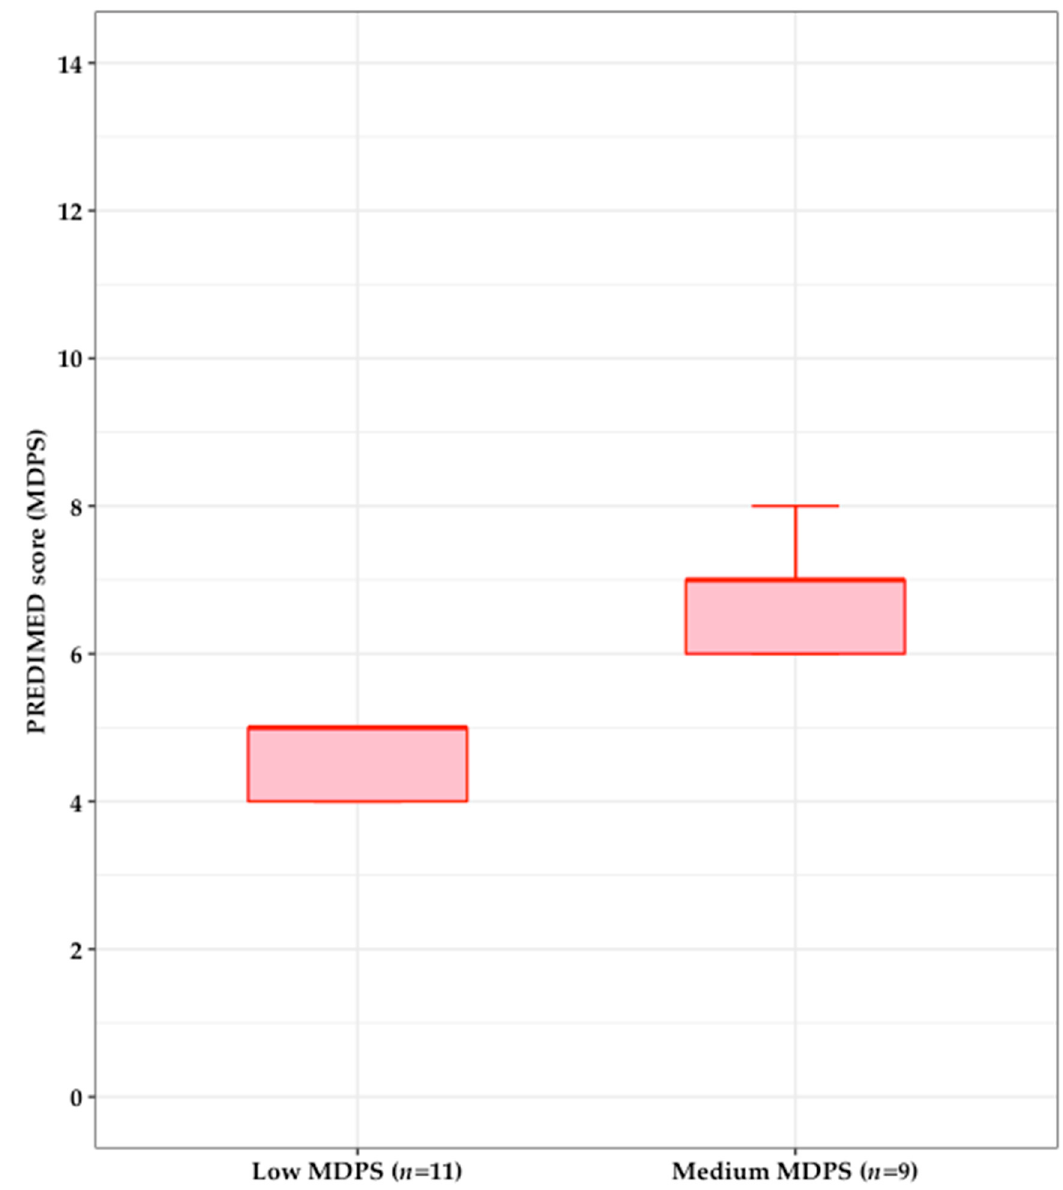
Figure 1. Participants’ adherence to the MD assessed using the PREDIMED score (MDPS). In the boxplot showing the distribution of PREDIMED score (MDPS), eleven participants scored low on MDPS ( ≤ 5) (median 5, range 4–5), and nine participants had scores in medium tertile (median 7, range 6–8). The dark red horizontal line is the median.